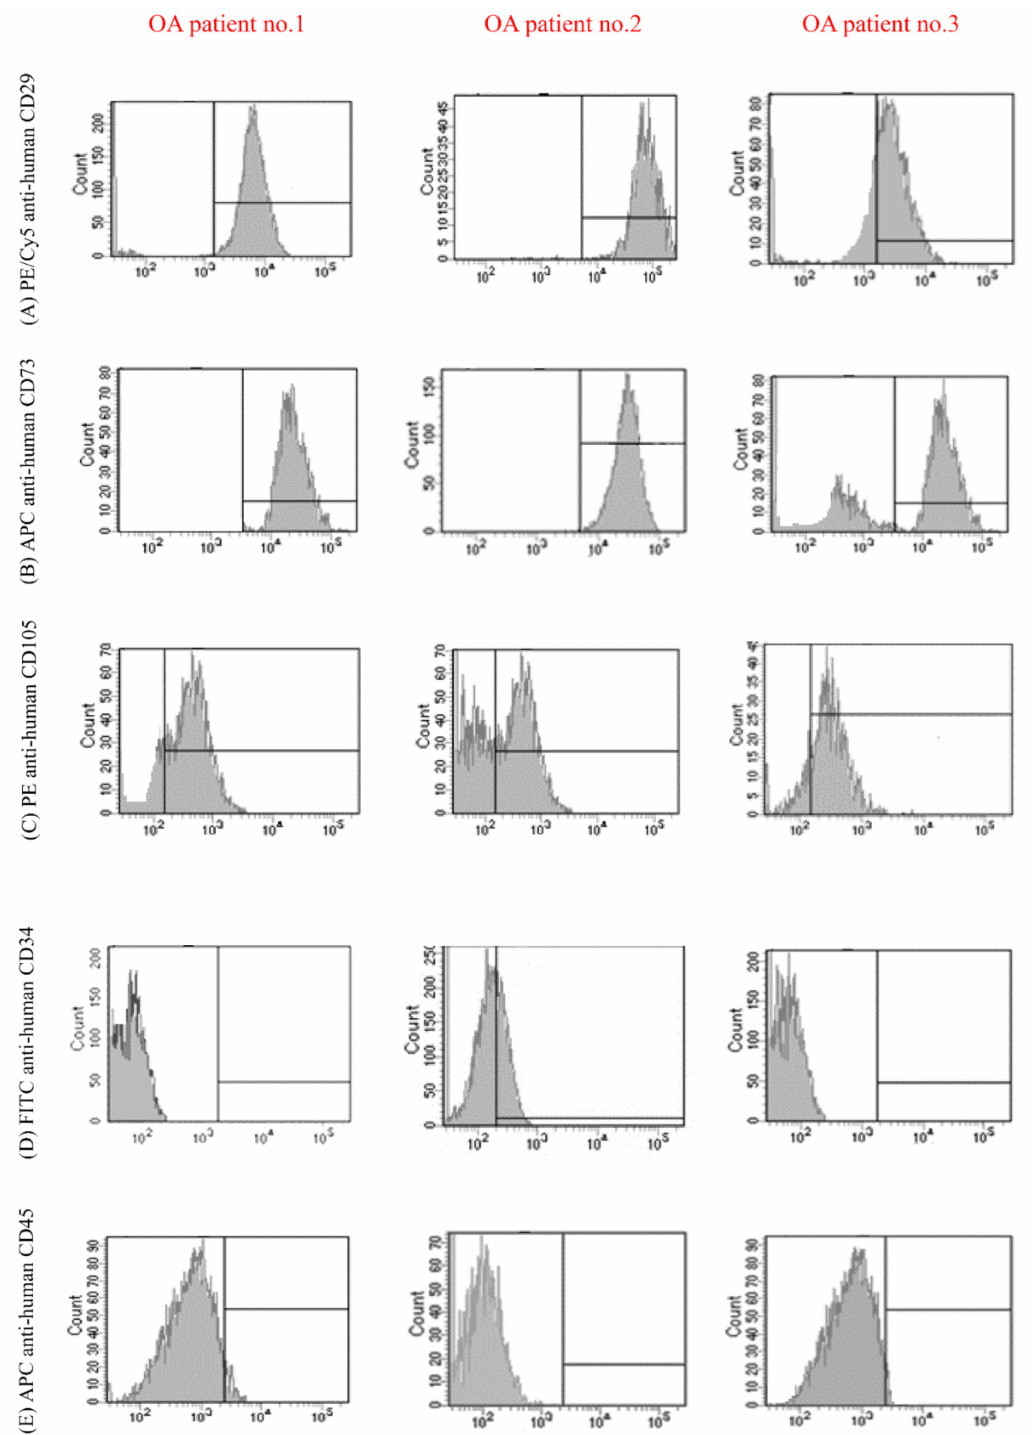
Figure 2. Flow cytometry analysis of the expression of cell surface markers protein in SPFP-MSCs from three OA patients. Cell cultures were positive for the MSC specific markers ( A ) CD29 = 92.30 ± 3.20%, ( B ) CD73 = 90.91 ± 2.73%, and ( C ) CD105 = 83.52 ± 3.23%. and negative for the hematopoietic stem cell markers ( D ) CD 34 = 1.04 ± 2.88% and ( E ) CD45 = 0.92 ±